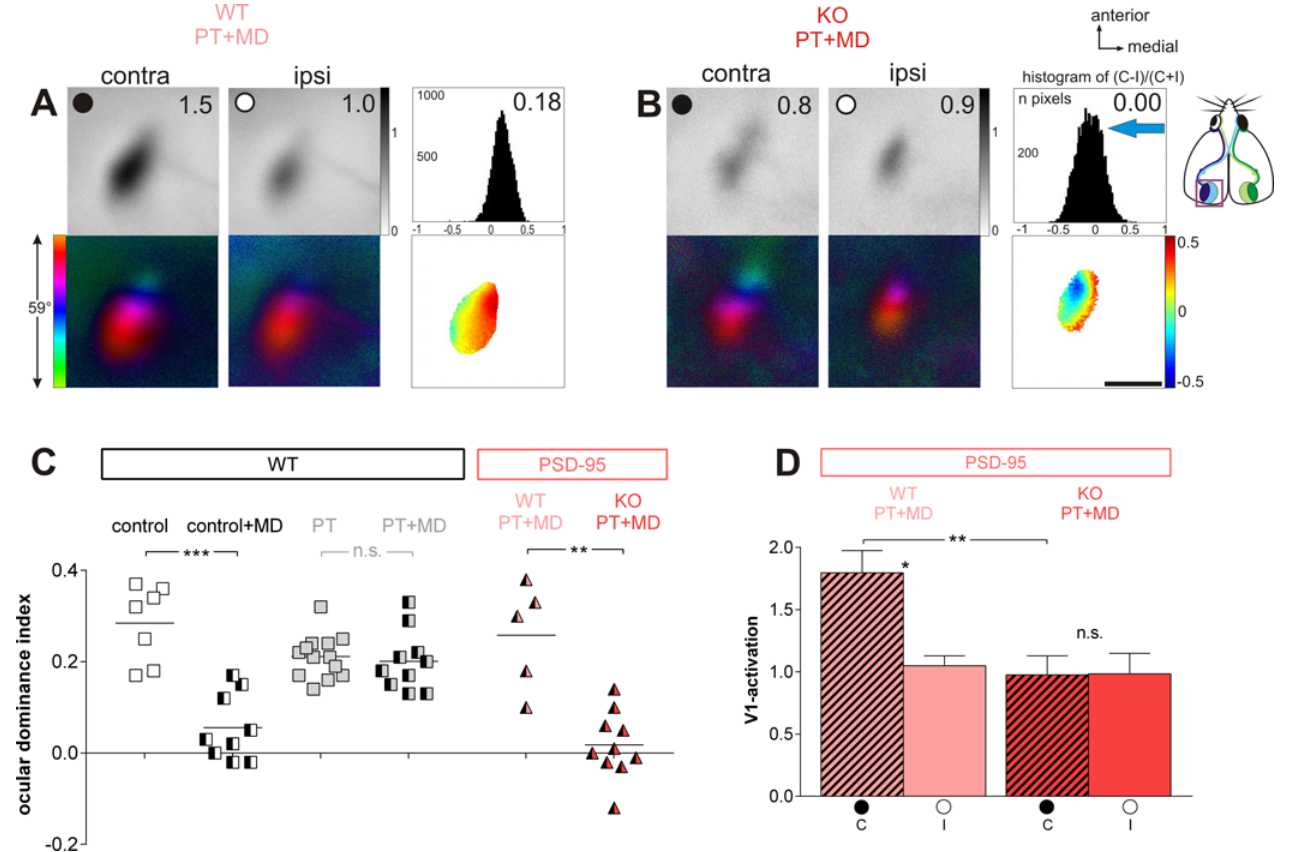
Fig 2. In adult PSD-95 KO mice, ocular dominance plasticity was preserved after a PT-stroke in S1. Optically recorded activity maps of the contralateral (contra) and ipsilateral (ipsi) eye in the binocular region of mouse primary visual cortex (V1) in PT-lesioned PSD-95 WT (A) and PSD-95 KO mice (B) after monocular deprivation (MD), and their quantification (C, D). Open and closed eyes indicated by a white or black circle. (A, B) Grayscale coded response magnitude maps of the contra- and ipsilateral eye (including average V1-activation of the illustrated example) and the histogram of OD-scores including the average OD-index (top row), color-coded polar maps of retinotopy and 2-dimensional OD-maps after MD (lower row) are illustrated. (A) In PSD- 95 WT littermates, activity patches evoked by stimulation of the contralateral eye were darker than those of the ipsilateral eye, the average ODI was positive, and warm colors prevailed in the OD-maps, indicating contralateral dominance. In contrast, in PSD-95 KO mice, the contra- and ipsilateral eye activated V1 about equally strong, colder colors appeared in the OD-map, and the histogram of OD-scores shifted to the left (B). Scale bar: 1 mm. (C) Optically imaged OD-indices in PT-lesioned PSD-95 WT and PSD-95 KO mice (light red and red triangles). For comparison, ODIs of control (sham-treated) and PT-lesioned Bl6/J mice are illustrated (white and grey squares). Symbols represent ODI values of individuals, means are marked by horizontal lines. (D) V1-activation elicited by stimulation of the contralateral (C) or ipsilateral (I) eye in PSD-95 WT and PSD-95 KO mice after PT and MD. Note that V1-activtation after stimulation of the contra- and ipsilateral eye was not different in PSD-95 KO mice, indicating preserved juvenile-like OD-plasticity in V1 despite the S1-lesion.